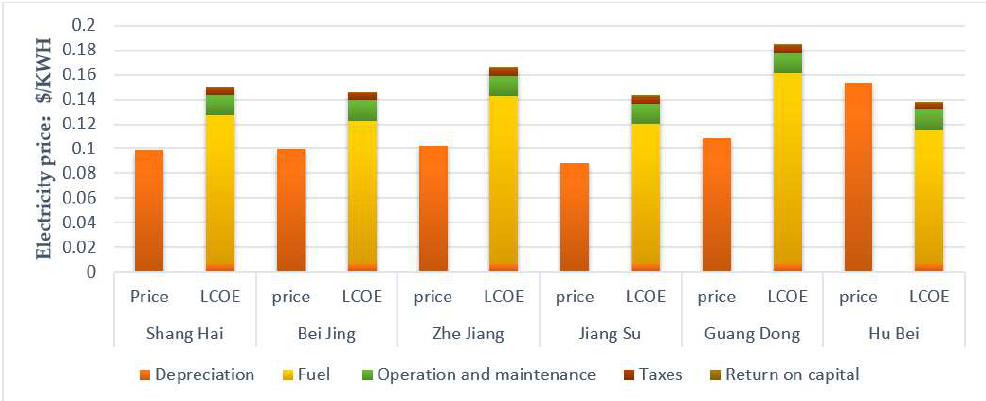
Figure 20. The LCOE and on-grid electricity prices in six typical provinces and cities.